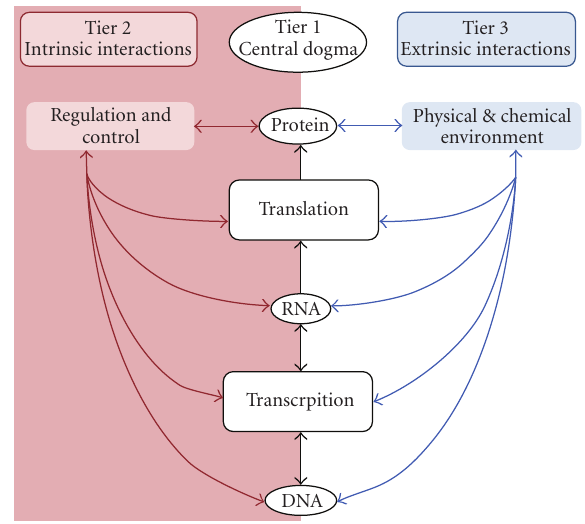
Figure 1: The central dogma with regulatory and environmental influences acting upon the process . The two central dogma process units (transcription and translation) and the three process streams (DNA, RNA, and protein) are depicted. These units and streams are all subject to control by both internal, regulatory and external, environmental conditions. These influences alter the central dogma process and regulatory mechanisms. Large bold arrows are used to indicate that proteins are the major workhorses of the cell, participating both in regulatory mechanisms and responding to the environment. Whether the system of interest is a signaling cascade or metabolic pathway, proteins are essential components and must become well understood and modifiable to bring about ground- up cellular optimization. Synthetic biology is developing tools to modify and control each unit and stream in this